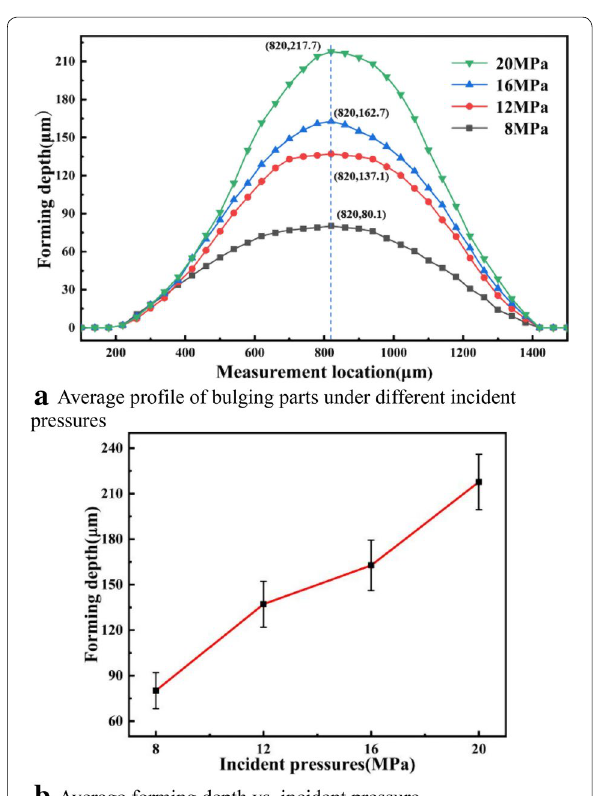
Figure 9 Average profile and forming depth of bulging parts under different incident